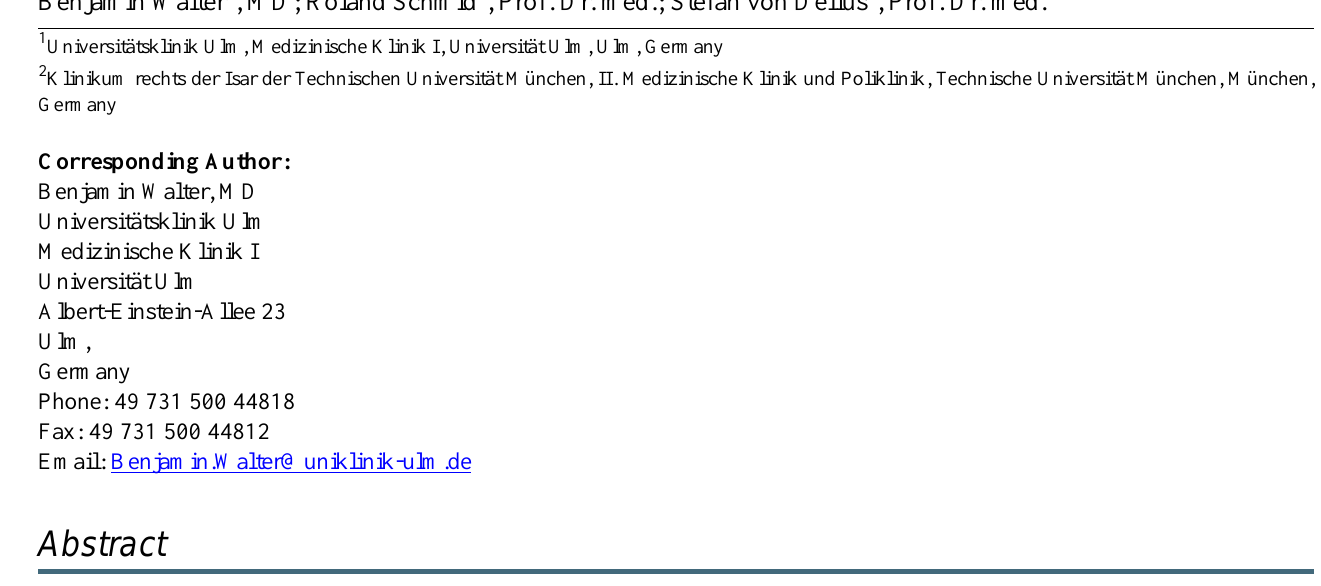
bowel preparation; smartphone app; intestinal cleansing; patient education; colonoscopy; colonoscopy